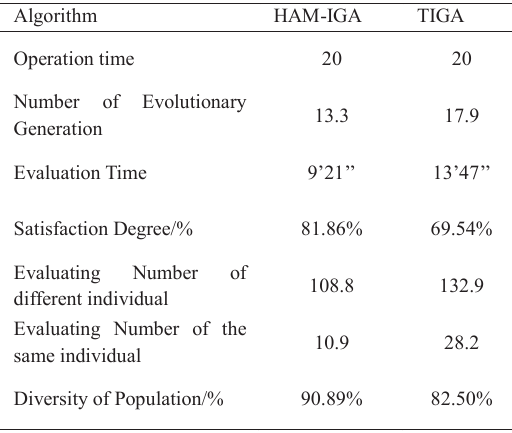
Table 3. Comparison of operational performance of HAM-IGA and